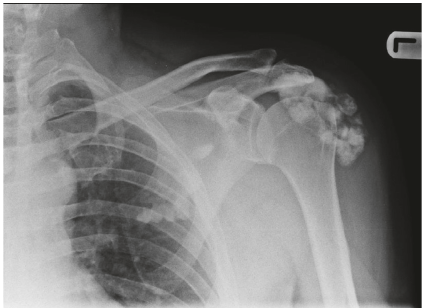
Figure 1: Anteroposterior radiographs of the left shoulder showing calcification over the greater tuberosity and subacromial space as well as classic hyperostotic lesions in the scapular blade.